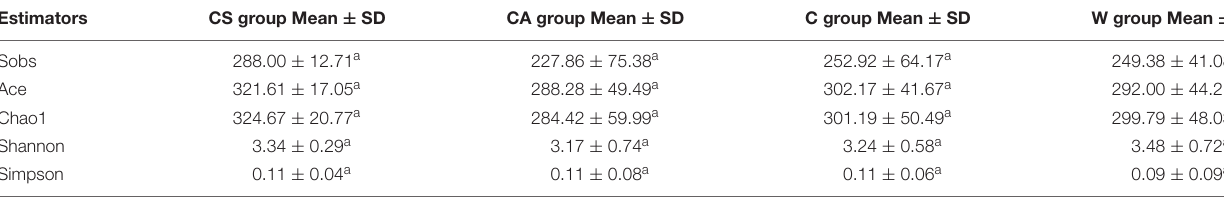
TABLE 1 | Alpha-diversity of the brown frog gut microbiota in different groups, as determined by Kruskal–Wallis rank sum test. Estimators